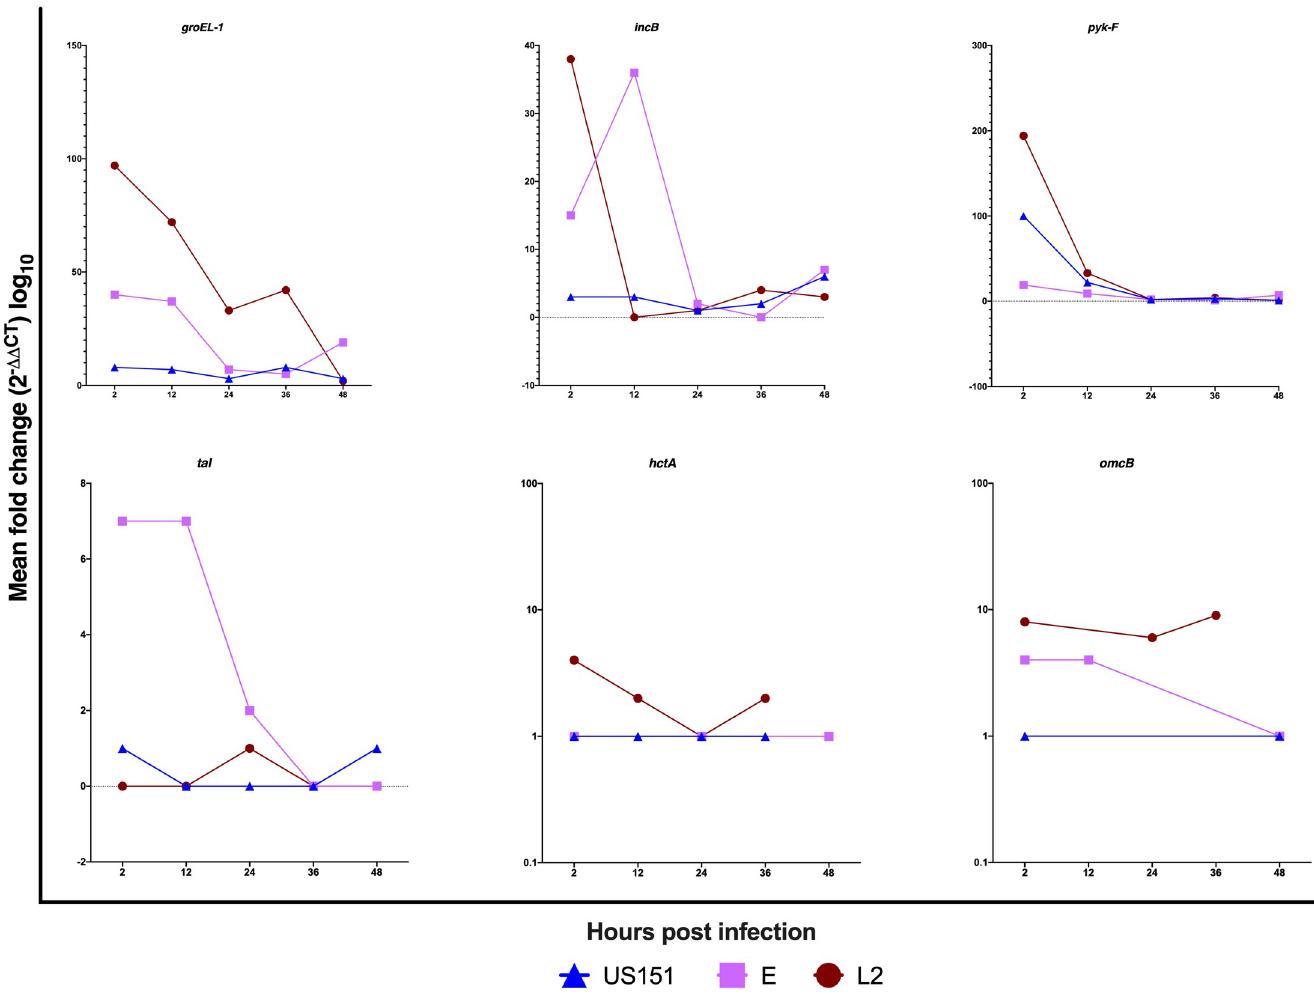
Fig 1. Line graphs representing the mean fold difference (2 - ΔΔ CT ) of the groEL-1 , incB , pyk-F , hctA , tal and omcB genes of C . trachomatis post infection in HaCaT cell lines with reference strain L2 434 and clinical isolates US151 (L2) and serovar E at 2, 12, 24, 36 and 48-hours. The standard deviations of the ΔΔ C T values were incorporated into the fold difference calculation and the results are based on experiments carried out three times in triplicates.